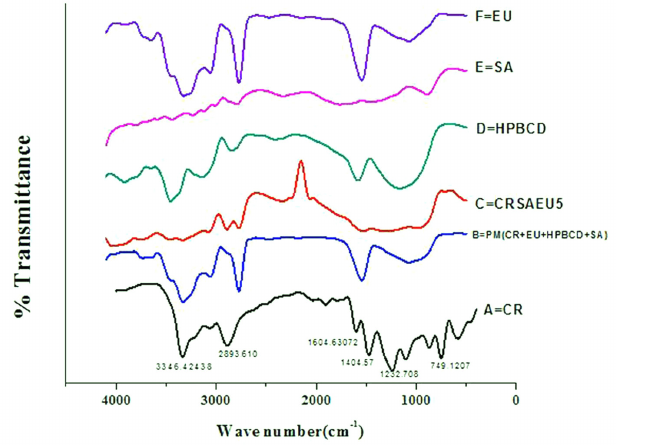
FIGURE 6 - X-ray diffractograms of CRSAEU5, pure carvedilol, pure HPBCD and amorphous